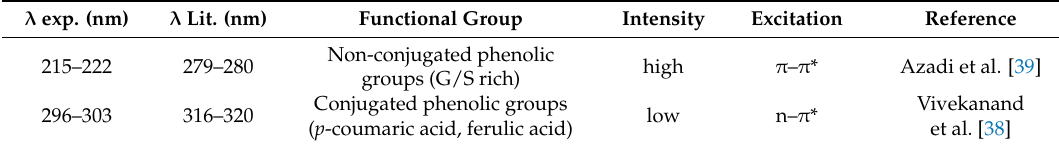
Table 3. Ultraviolet-visible (UV/Vis) absorption data of lignin and their characteristics. λ exp.